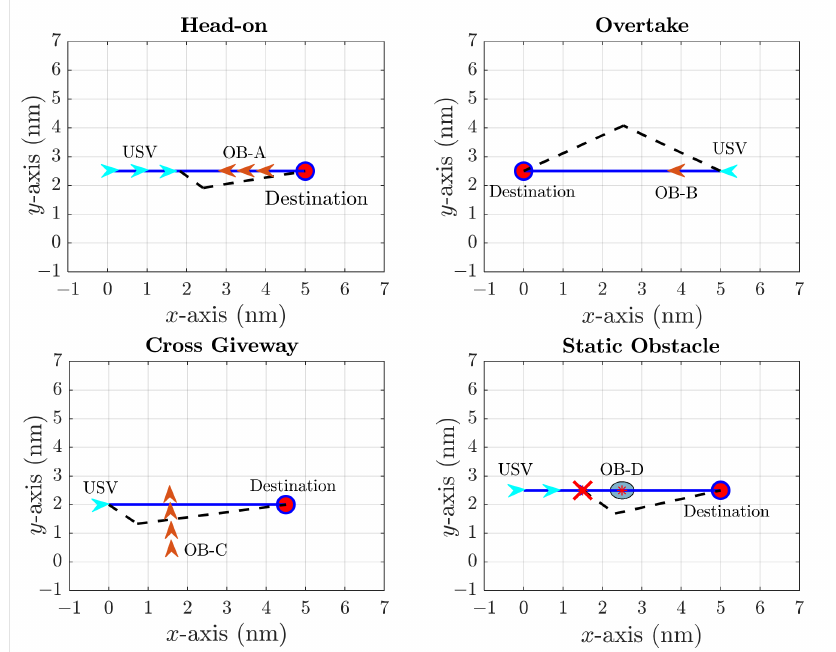
Figure 8. Numerical simulation results for USV path planning with dynamic and static obstacles.